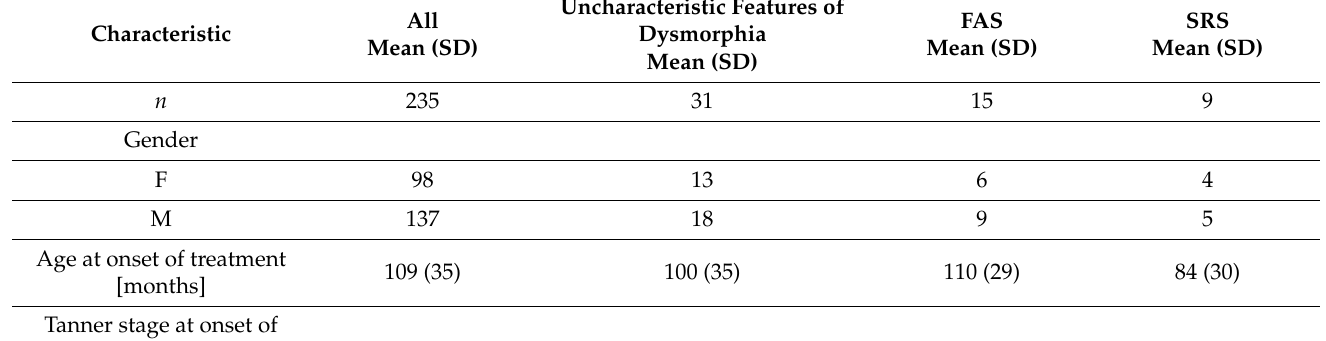
treatment was 0.031 mg/kg/d. The characteristics of the study group are shown in Table 1. Table 1. Selected background characteristics of the study